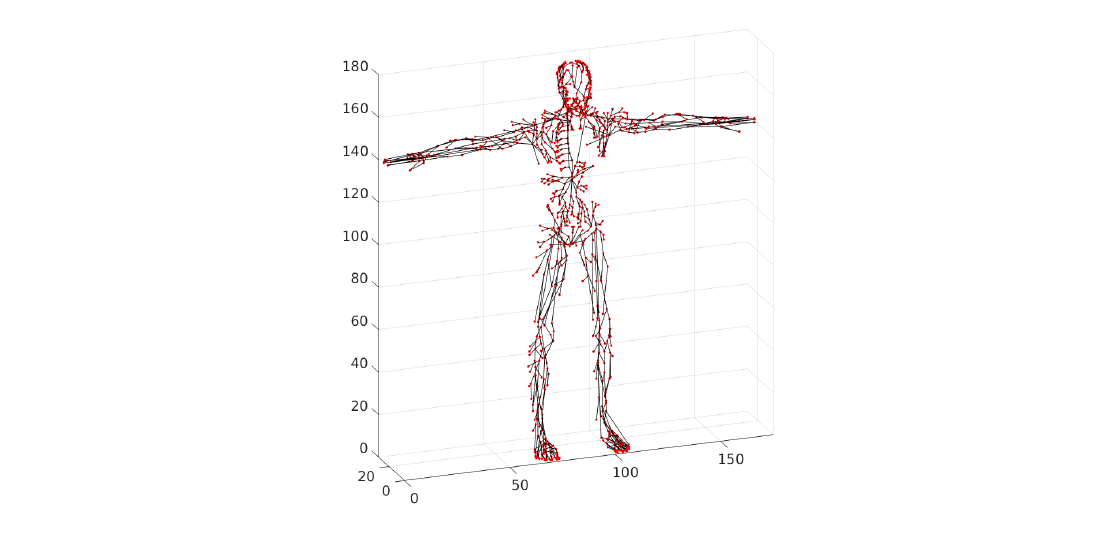
Figure 12. The skeleton graph of the lymphatic system network. Red color stands for vertices, and black color designates the edges.